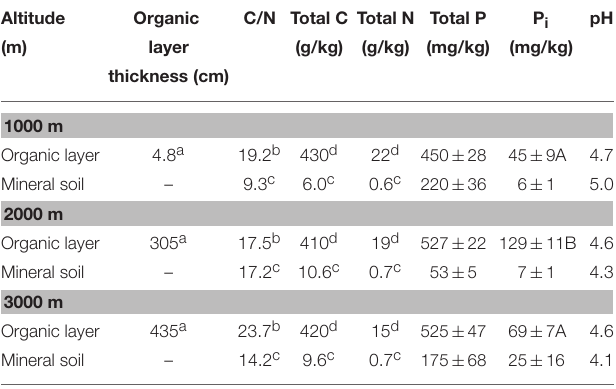
TABLE 1 | Characteristics of the soil at the three NUMEX